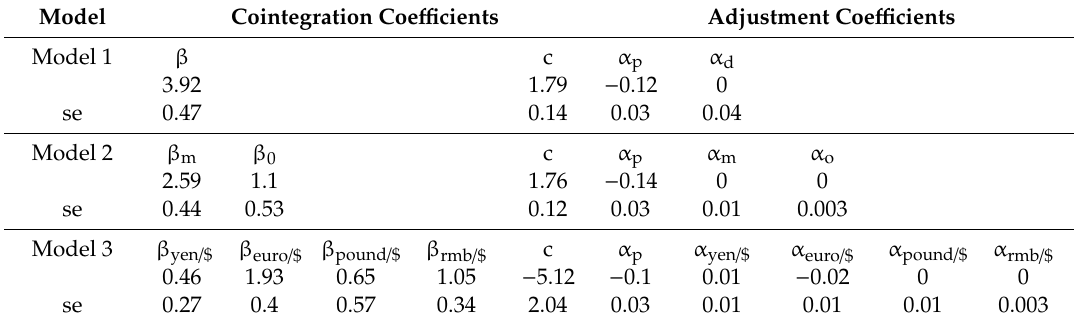
Table 4. Cointegration Results—1999:1–2018:12-Johansen